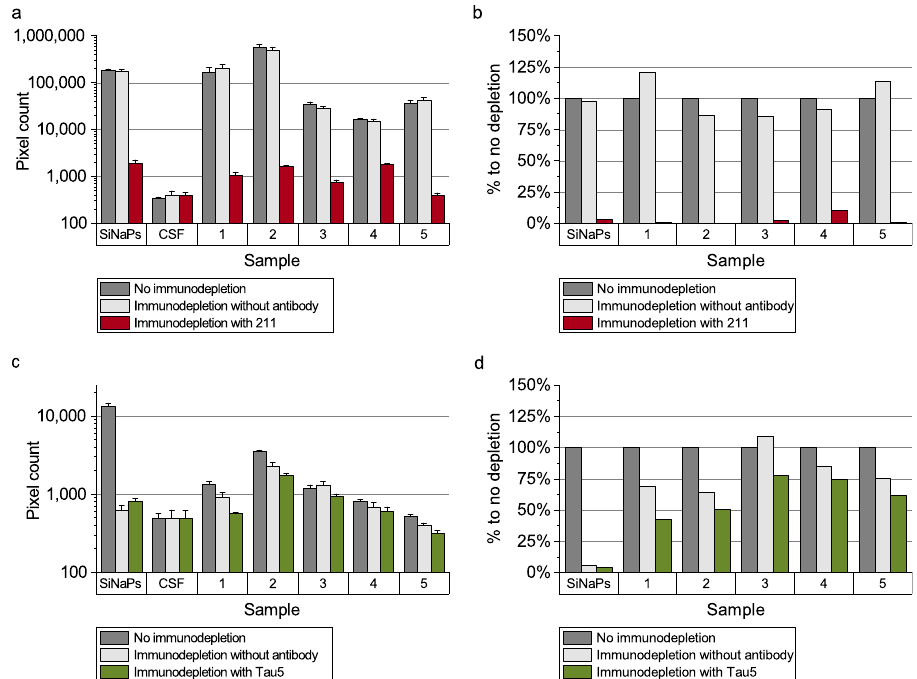
Fig. 7 Immunodepletion of aSyn and Tau in CSF samples. The SiNaP standard and fi ve CSF samples were subjected to immunodepletion with magnetic beads with and without antibody. a , b Immunodepletion of samples with 211 antibody decreased the pixel counts for aSyn on average by 97%, while incubation with magnetic beads without antibody did not affect the signal. c , d For aggregated Tau, incubation with magnetic beads without antibody decreased the pixel count by 94% for Tau SiNaPs and on average by 19.5% for samples. Using Tau5 antibody, the decrease of the pixel count for Tau SiNaPs was 95% and for samples 38.6%, respectively. The % to no depletion value (Fig. 7 b , d ) was calculated by the ratio the pixel counts of depleted to non-depleted samples. Standard deviation was calculated from the four replicates.